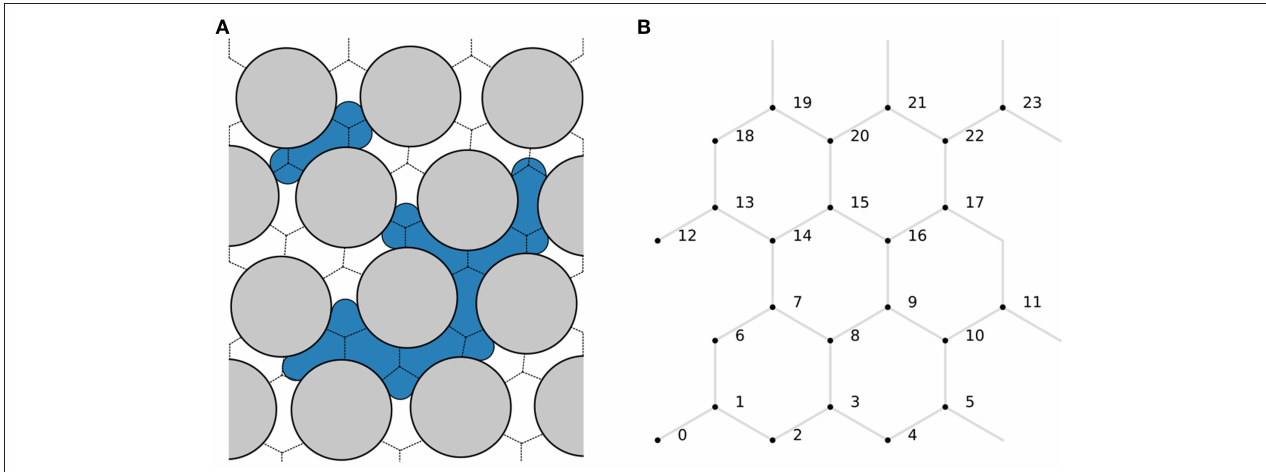
FIGURE 1 | Illustration of (A) a physical pore network with wetting (white) and non-wetting fluid (blue) and (B) its representation in the pore network model. The void space volumes separated by dashed lines in (A) are each represented as one link in (B) . The node points in the model representation (B) is assumed to be located at the intersection points of the dashed lines in (A) . Each fluid is assumed to fill the entire link cross section. The interface positions are therefore each represented in the model by a single number, giving its location along the link